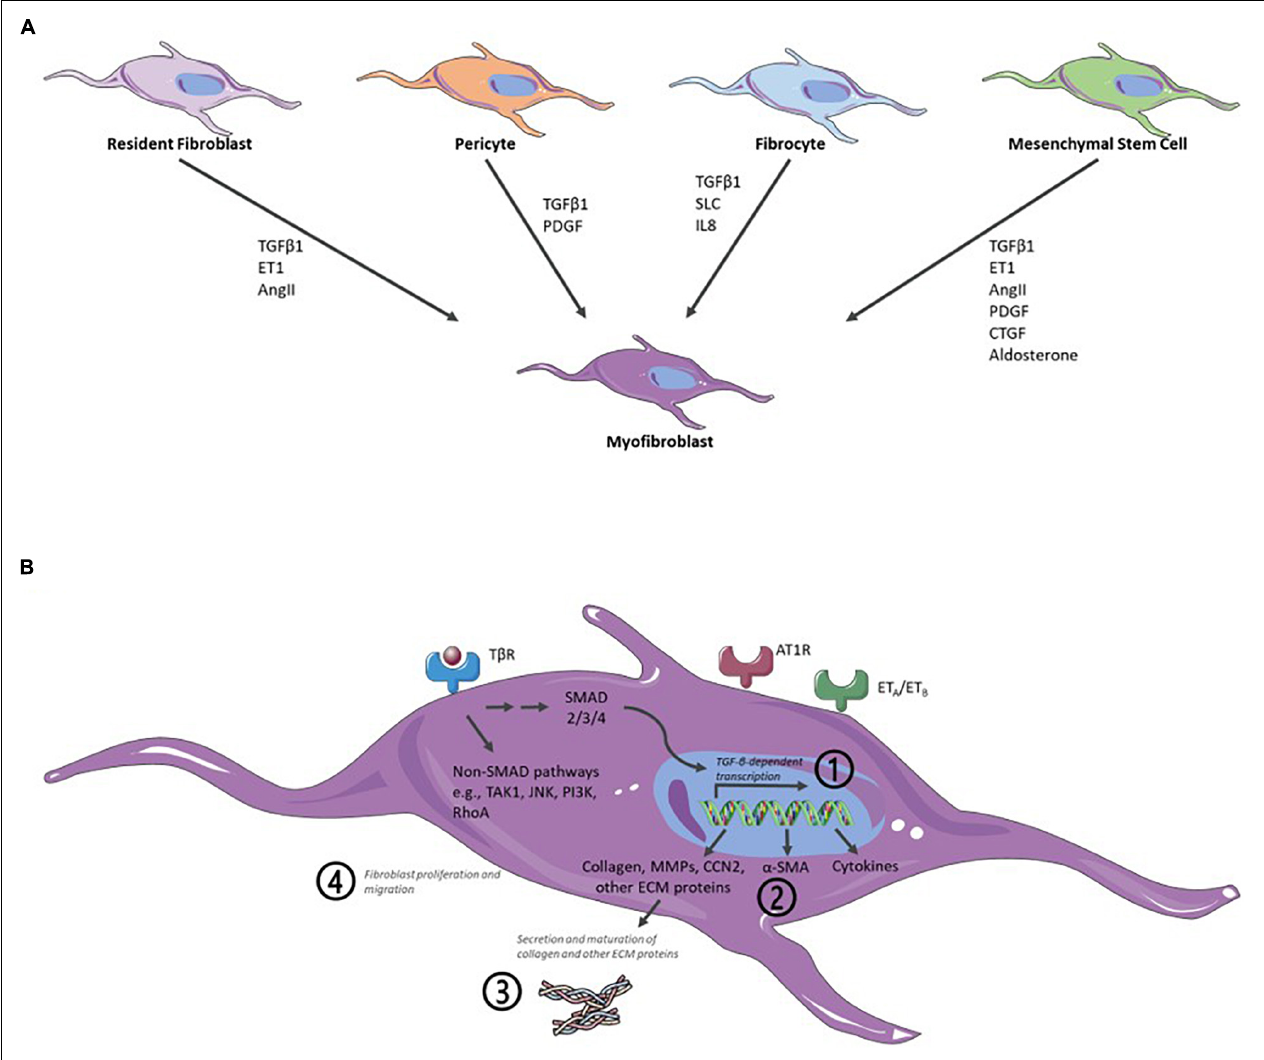
FIGURE 2 | Schematic representation of major biochemical pathways involved in the formation of myofibroblasts (myoFBs), activation of cardiac fibroblasts (CFs), profibrotic signaling, and key readouts for in vitro assays. (A) In vivo formation of myoFBs occurs from different cell types including resident fibroblasts, pericytes, fibrocytes, or mesenchymal stem cells, stimulated by mediators such as TGF β 1, ET1 (endothelin 1), AngII (angiotensin II), PDGF (platelet-derived growth factor), SLC (secondary lymphoid chemokine), IL8 (interleukin-8), CTGF (connective tissue factor), or aldosterone. (B) Activation of CFs is triggered by a myriad of cytokines and growth factors, such as TGF- β , CCN2 (connective tissue factor 2), PDGFs, AngII, aldosterone, endothelin-1, TNF α (tumor necrosis factor α ), IL1- β (interleukin-1 β ), or IL6 (interleukin-6). Activation of TGF- β receptor (T β R) leads to activation of downstream canonical SMAD and noncanonical pathways. The majority of cardiac fibrosis assays rely on measuring one of four major readouts: (Kong et al., 2014) TGF- β pathway activation/TGF- β -dependent gene expression; (Liu et al., 2017) α -SMA expression; (Gabbiani et al., 1971) (mature) collagen detection; and (Skalli et al., 1989) fibroblast proliferation or migration. Angiotensin II receptor type 1-mediated (AT1R) signaling and endothelin receptor-mediated (ET A /ET B ) signaling also contribute to cardiac fibrosis. As an excellent, in-depth review of signaling for the formation of myoFB and activation of CF, the reader is referred to the study of Aujla and Kassiri (2021). Figure created using Servier Medical Art by Servier (https://smart.servier.com/), licensed under a Creative Commons Attribution 3.0 Unported